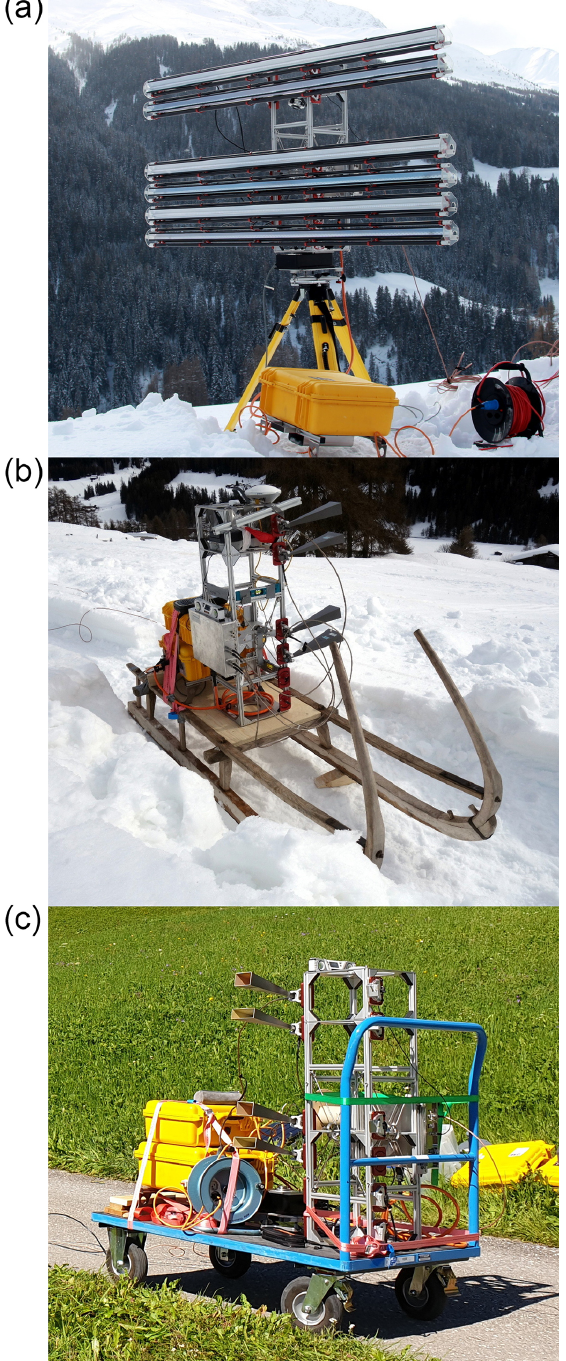
Figure 3. (a) Primary KAPRI radar tower (monostatic transmitter– receiver) during the ground-based experiment equipped with narrow-beam traveling-wave antennas. (b) Secondary KAPRI radar tower (bistatic receiver) equipped with horn antennas and deployed on a sledge ( Hornschlitten ) in winter. (c) Secondary KAPRI tower deployed on a wheeled cart in summer.